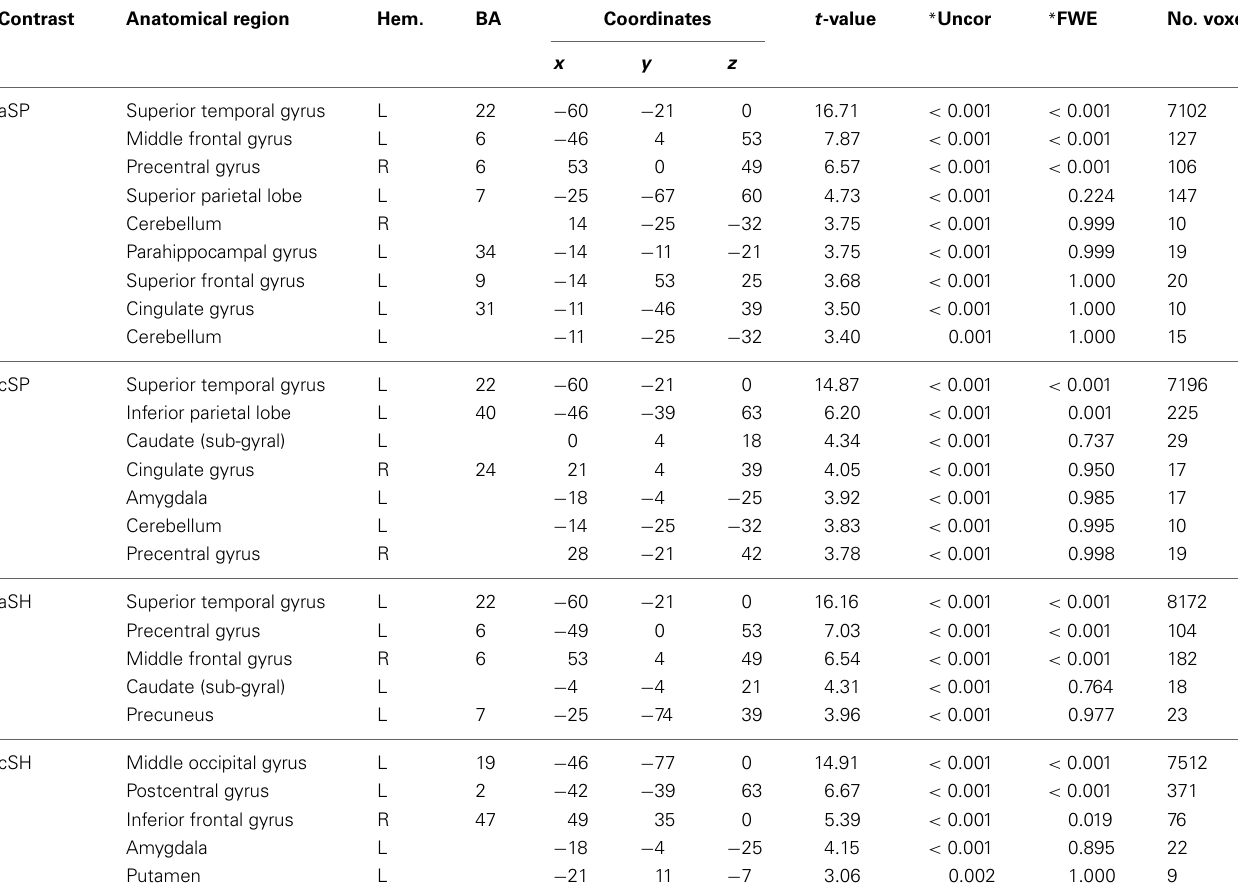
Table 3 | Gesture conditions in contrast to low level baseline (fixation